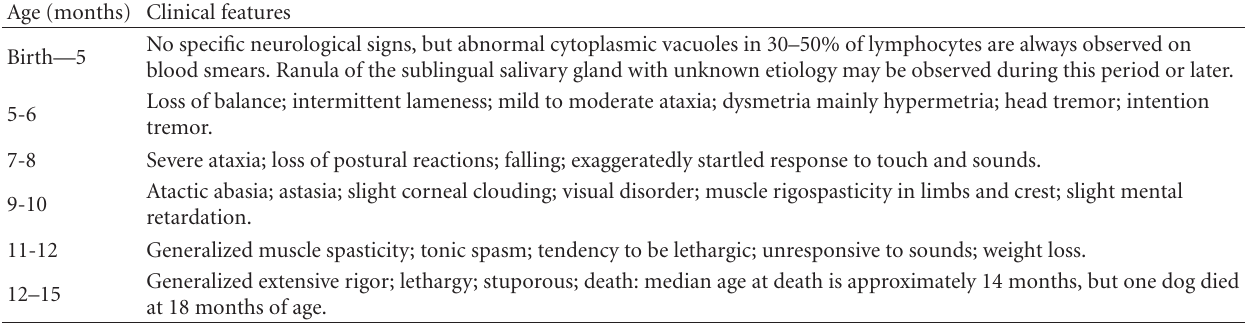
Table 1: Summary of clinical features in Shiba Inu dogs with GM1 gangliosidosis.